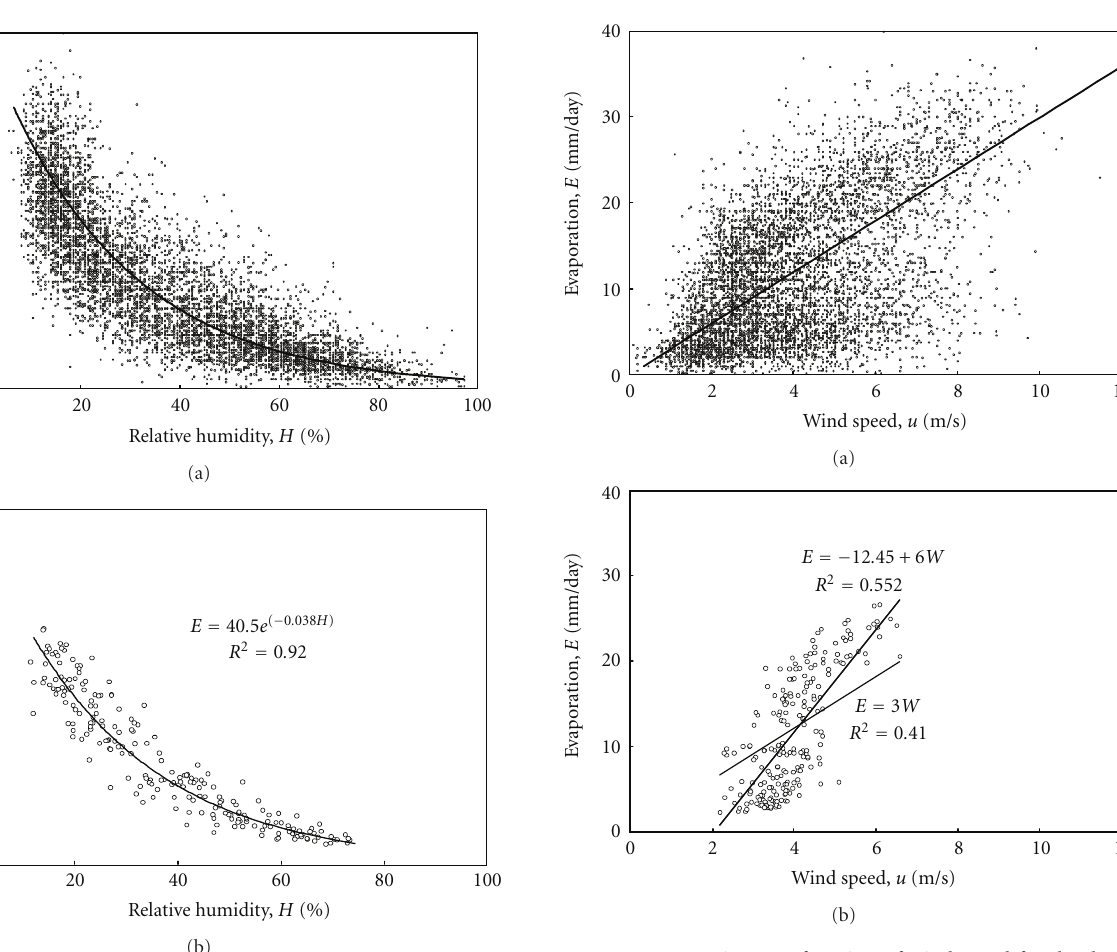
Figure 4: Evaporation as a function of wind speed for the data of Kuwait from 1993 to 2009. The solid curves represent suggested relations fitted using regression analysis. (a) Daily average data; (b) monthly average data. Table 3: Fitting accuracy of regression models using monthly aver- age meteorological data for Kuwait from 1993 to 2006 (calibration